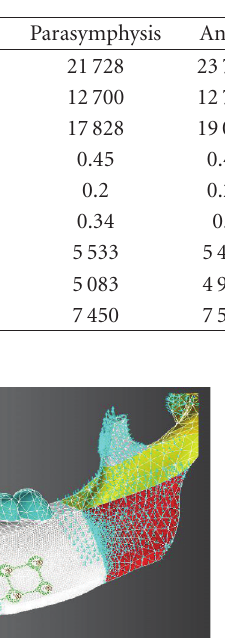
Table 2: Material properties used in FEA of the mandible. Orthotropic properties were used for cortical bone, while isotropic properties were used for cancellous bone, dentin, and the titanium plate. The x -direction is along the length of the mandible, the y -direction is normal to the bone plane, and the z -direction is their cross product.